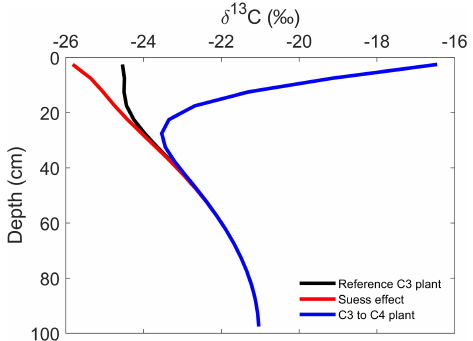
Figure 5. Effects of plant type change and the Suess effect on the δ 13 C profiles. In the reference C 3 plant scenario, the δ 13 C value of C inputs was set to be − 26‰; in the Suess effect scenario, the δ 13 C value of C inputs decreased from − 26‰ to − 28 . 5‰ gradually. In the scenario of conversion from C 3 plants to C 4 plants, the δ 13 C value of C inputs was set to be − 13‰ after vegetation